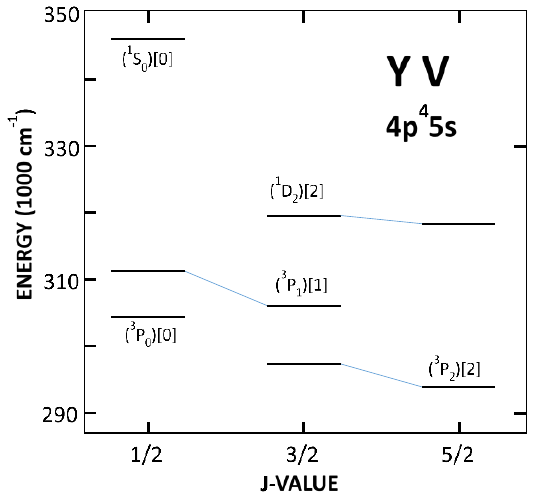
Figure 3. Structure of the 4s 2 4p 4 5s configuration of Y V.